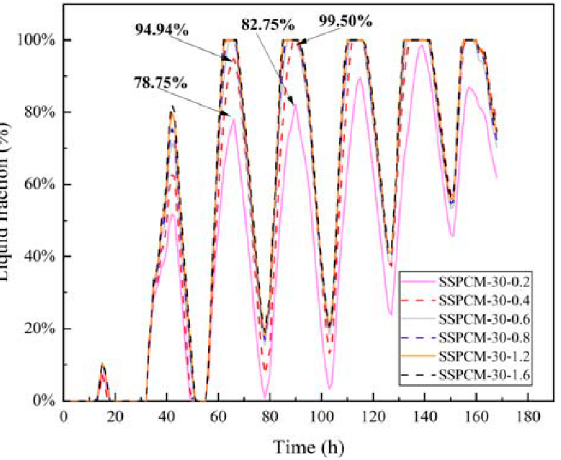
Figure 16. The internal surface temperature of the SSPCM layer at different thermal conductivities.